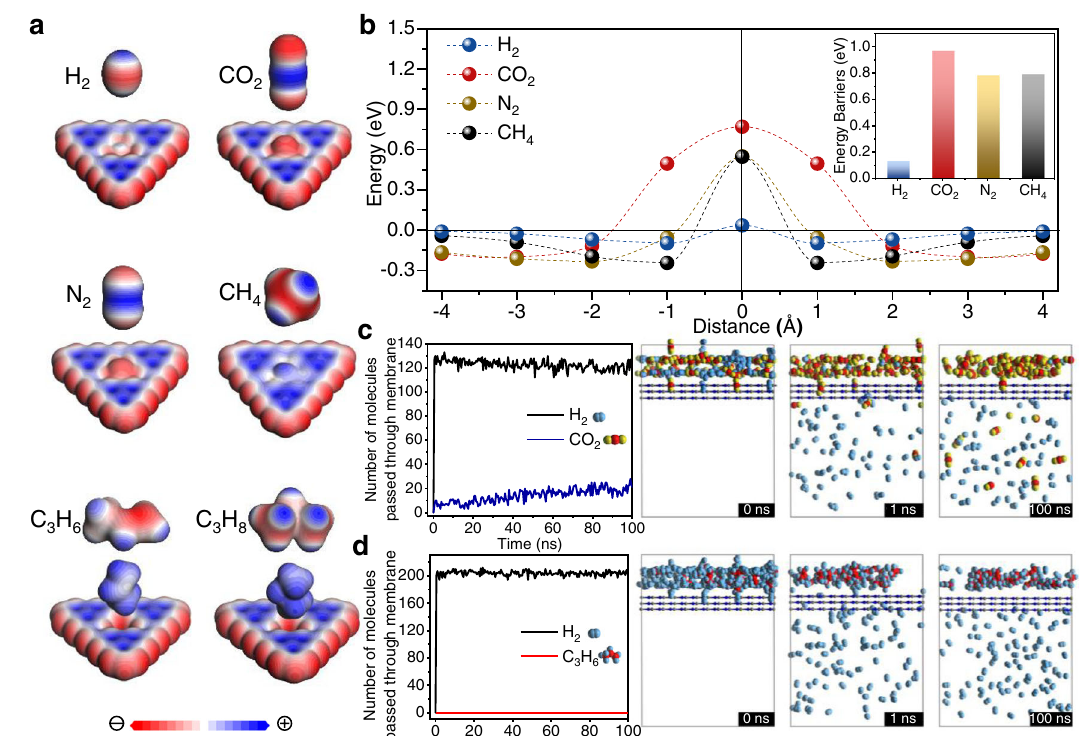
Fig. 4 | Gas separation mechanism of the g-C 3 N 4 layer. a Schematic illustrations ofgasmoleculeswithelectrostaticpotentialsdistributionthroughtheg-C 3 N 4 layer. b PotentialenergysurfacesforH 2 ,CO 2 ,N 2 ,andCH 4 ontheg-C 3 N 4 layer.Insetisthe energy barrier for gas molecules across the monolayer g-C 3 N 4 . The number of gas moleculesof c H 2 /CO 2 mixturesand d H 2 /C 3 H 6 mixturesthroughtheg-C 3 N 4 layerin